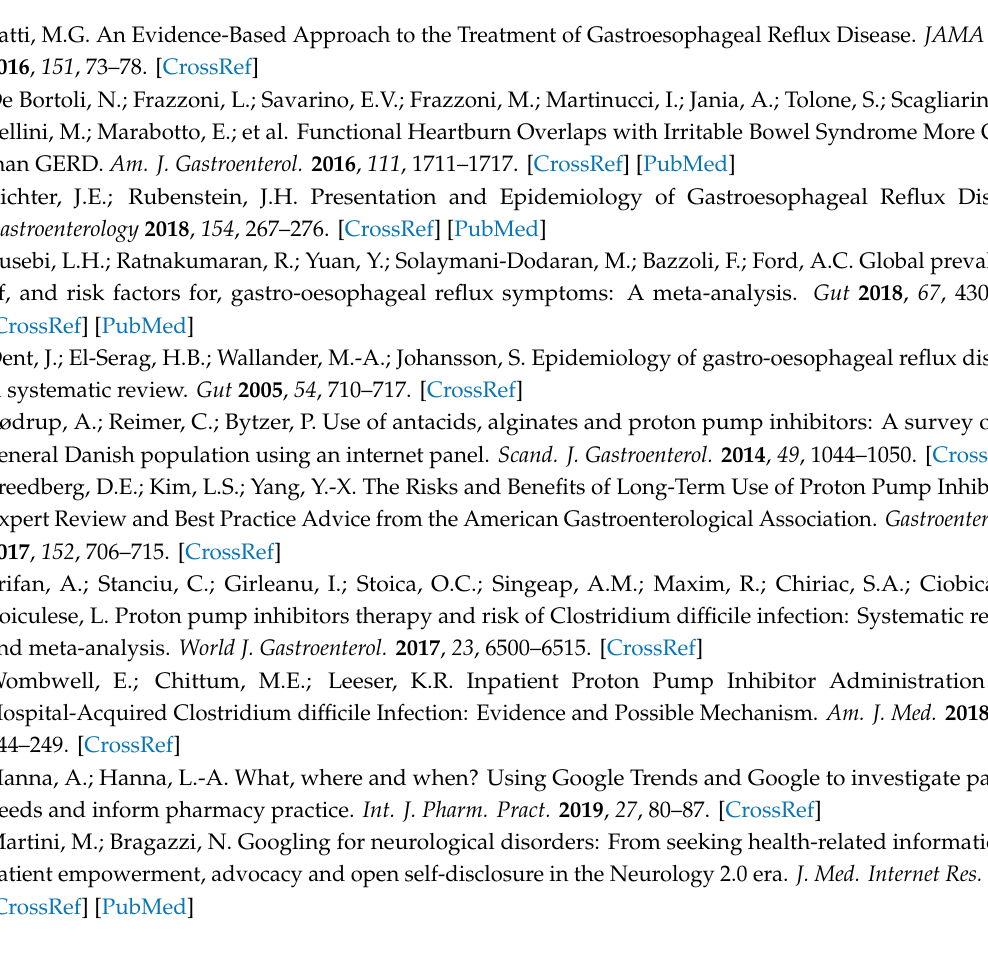
Table S1: The top 20 keywords for each analyzed countries. Data presented as total number of queries of each keyword (percentage of total number of all keywords in the country); Table S2: Comparison between the number of searches per month in the Google search engine of categories of keywords associated with heartburn in the analyzed countries in each season (1a) and each year (1b). Data are presented as median (interquartile range); Figure S1: Screenshot of the keyword search engine of Google Ads Keywords Planner; The blue frame encapsulates the control for setting the time period of the search; brown frame—total number of related keywords found (“keyword ideas”); green frame—search bar for user-entered search terms; orange frame—control for setting the language and geographical region of the search, as well as the search network; pink frame—button for downloading a .csv file of the search results; red frame—long list of keywords; violet frame—monthly search volume for each keyword; Figure S2: Flow chart of the data collection and manipulation